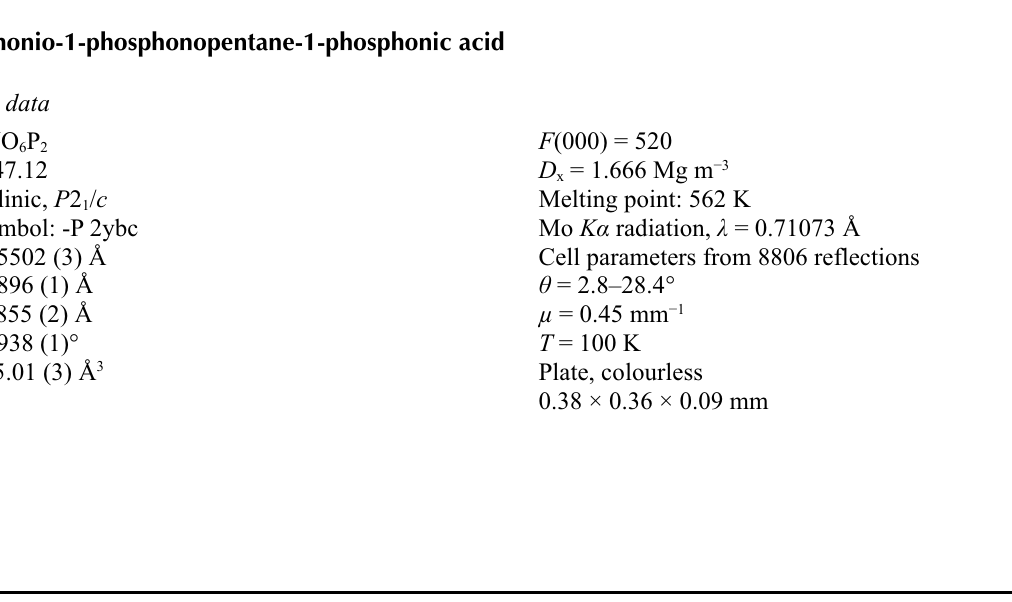
Crystal packing of the title compound; projection along b axis. Dashed lines indicate hydrogen